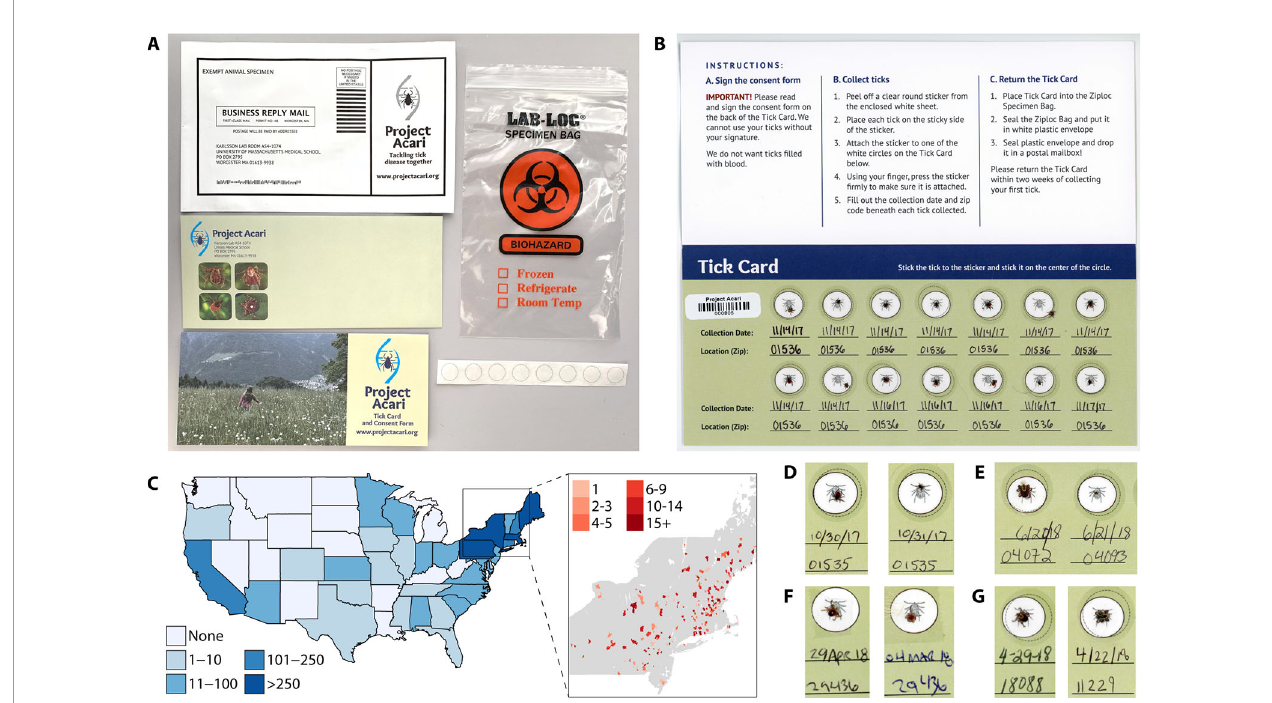
FIGURE 1 | Citizen science approach enables large-scale collection of many tick species from a broad geographic area. (A) Our custom-designed “ Tick Kit ” includes a Tick Card, clear stickers to adhere ticks to the Tick Card, as well as a sealable biohazard bag and prepaid plastic envelope for return shipping. All components fi t into standard fi rst-class mail envelopes for fast and inexpensive shipping in both directions. (B) A returned Tick Card with 14 ticks, the maximum capacity of the Tick Card, each sealed on the card with a clear sticker and labelled by the volunteer with collection data and location (zip code). Each Tick Card has a unique barcode